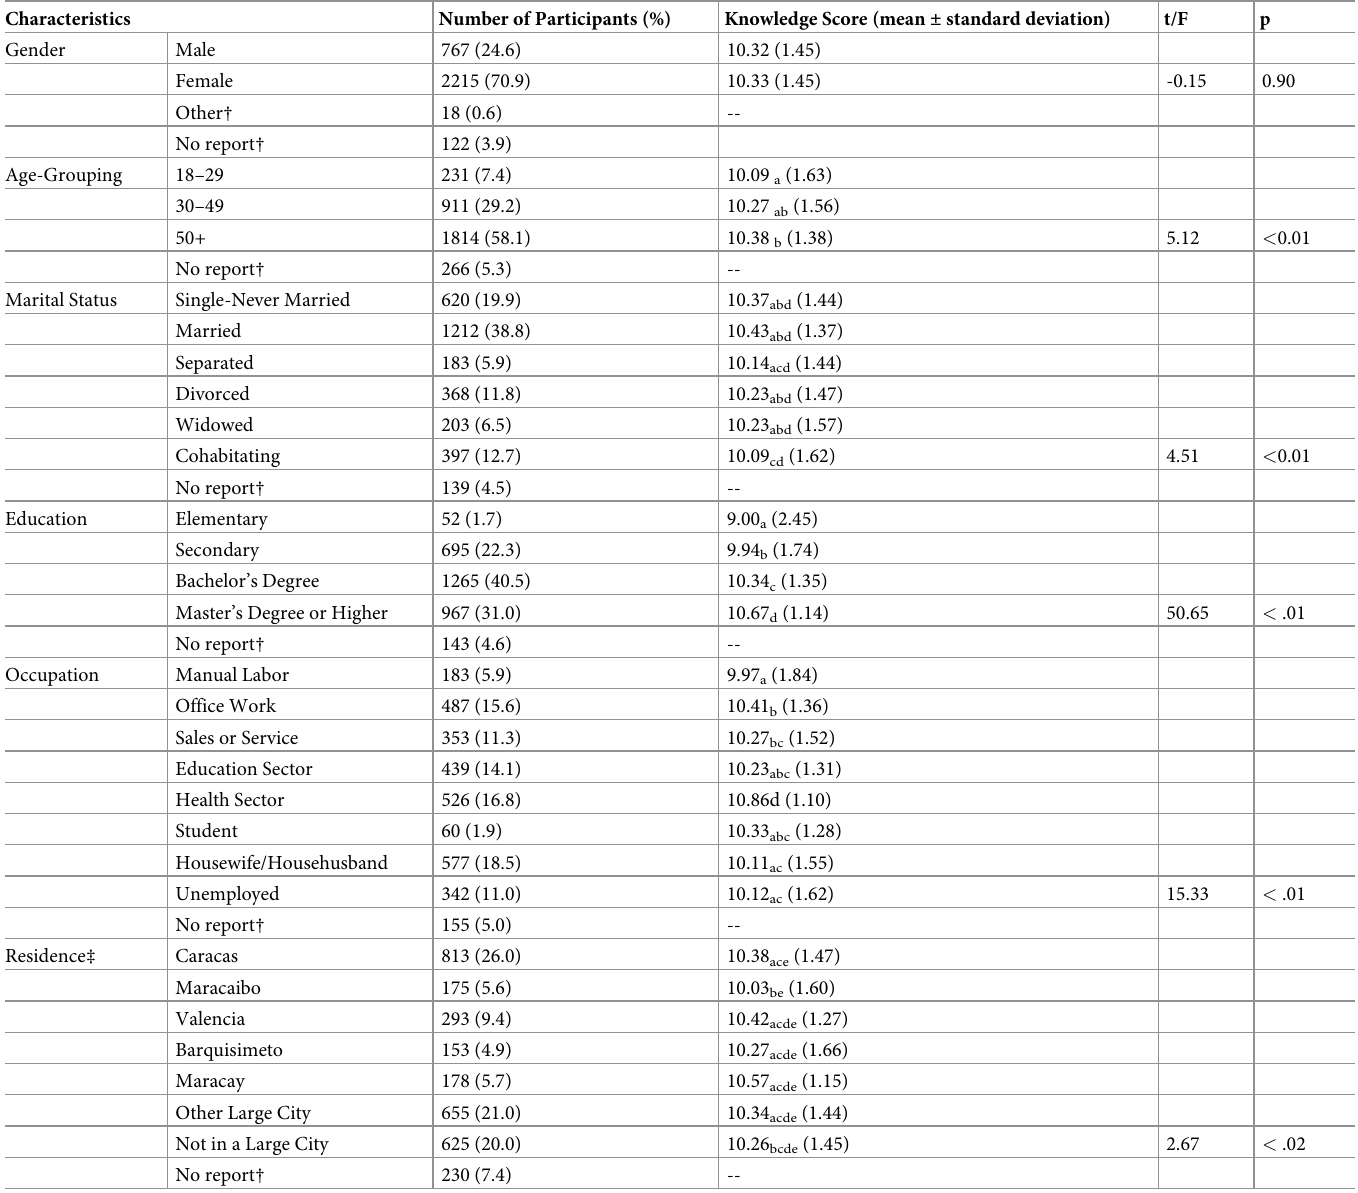
Table 2. Demographic characteristics and COVID-19 knowledge score differences.